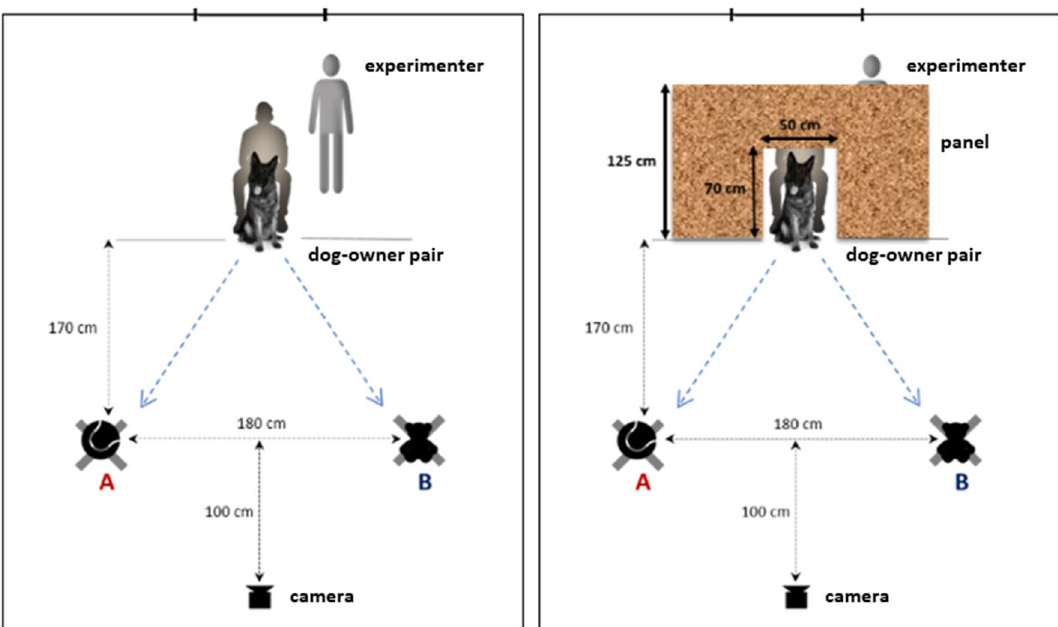
Figure 1. Experimental setup displaying the two cue-control conditions. Left image shows the setup without panel, right image shows the setup with panel between the owner and the objects. Object positions are indicated with A and